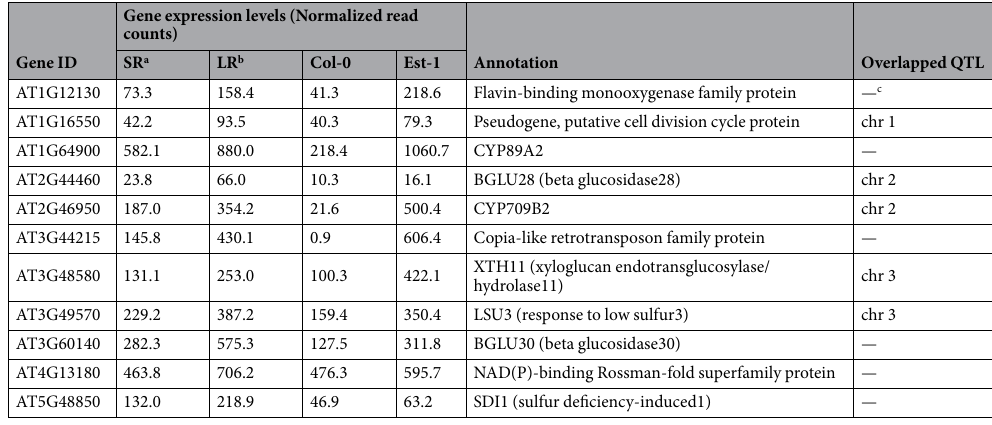
Table 1. Genes highly expressed in primed seeds of high longevity genotypes (bulked-long RILs and Est-1). a SR; bulked-short RILs. b LR; bulked-long RILs. c No overlap with the